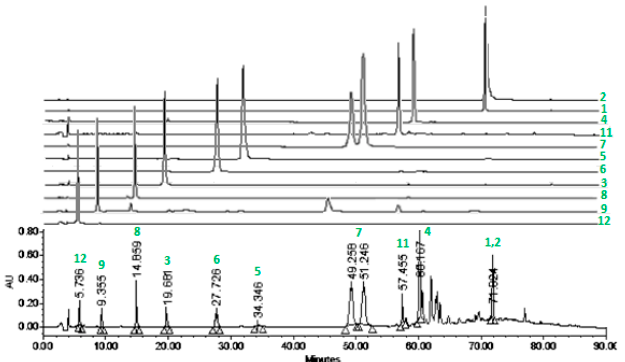
Figure 4. Chromatogram of propolis extract (5 mg/mL, 20 µ L injection) at 236 nm. ( 1 ) ( λ max 289 nm), ( 2 ) ( λ max 266.6 nm), ( 3 ) ( λ max 277.2 nm), ( 4 ) ( λ max 290.2 nm), ( 5 ) ( λ max 266.6 nm), ( 6 ) ( λ max 291.4 nm), ( 7 ) ( λ max 327 nm), ( 8 ) ( λ max 322.2 nm), ( 9 ) ( λ max 323.4 nm), ( 10 ) ( λ max 236 nm), ( 11 ) ( λ max 324.6